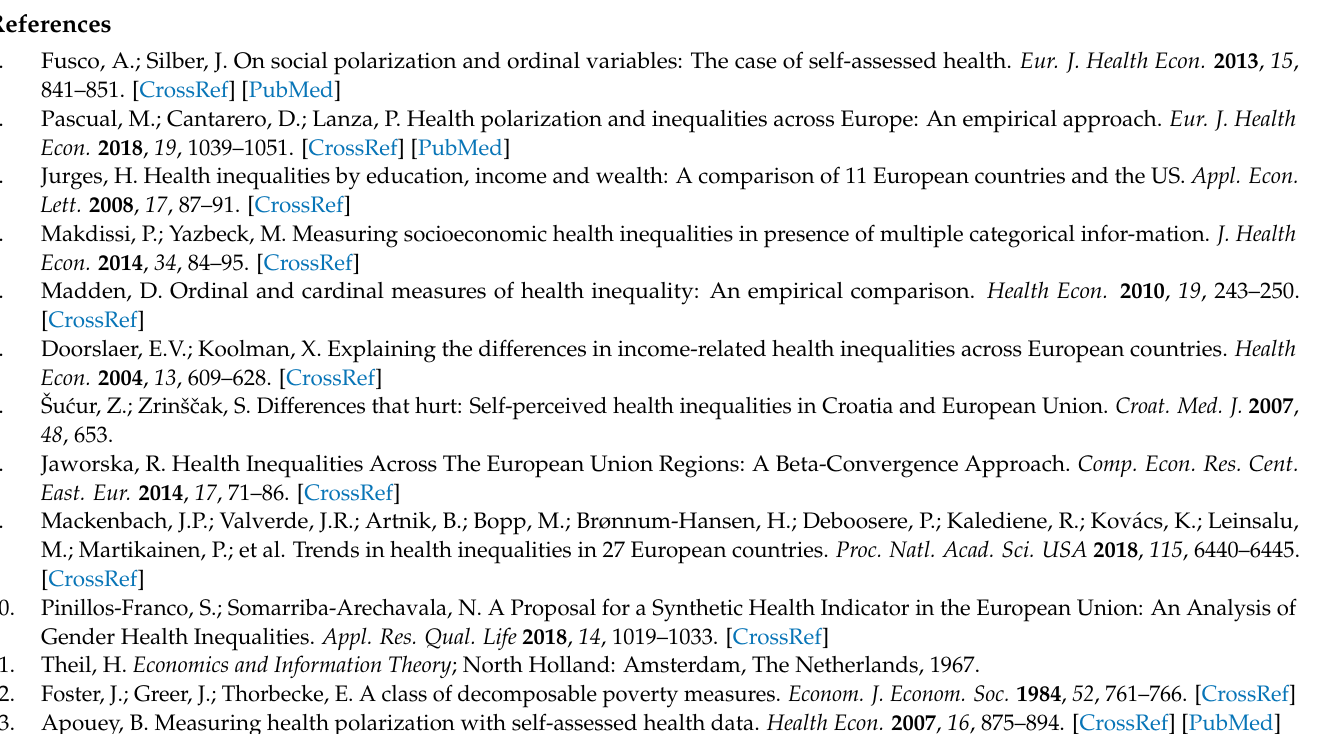
Figure A6. Distribution of women in Wave 8 (2020). Source: Authors’ elaboration based on SHARE (2021).